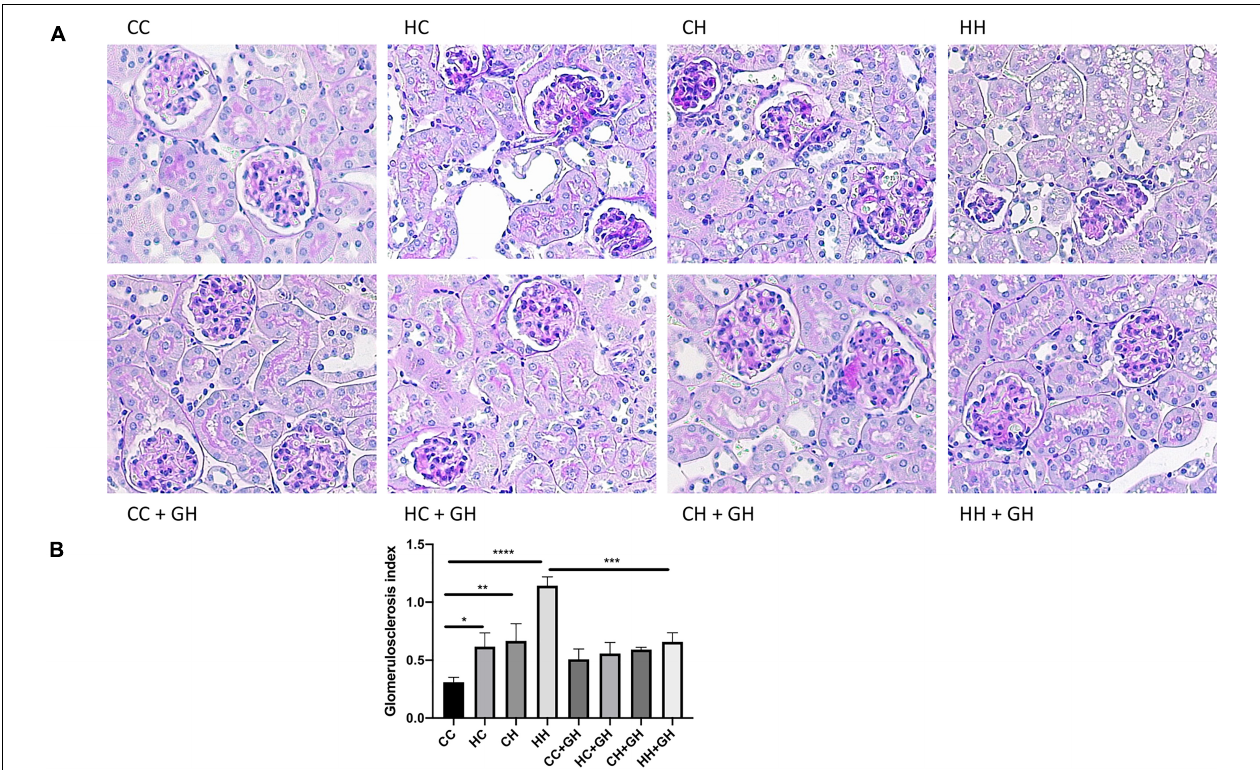
FIGURE 4 | Glomerulosclerosis. (A) Representative images of PAS staining for glomerulosclerosis at 400x magnification, (B) glomerulosclerosis index. Results expressed as mean ± SEM, n = 6. * p < 0.05, ** p < 0.01, *** p < 0.001, **** p < 0.0001. CC, control offspring; HC, lean offspring of obese mothers; CH, obese offspring of lean mothers; HH, obese offspring of obese mothers; CC + GH, control offspring exposed to gestational hydralazine; HC + GH, lean offspring of obese mothers with gestational hydralazine; CH + GH, obese offspring of lean mothers with gestational hydralazine; HH + GH, obese offspring of obese mothers with gestational